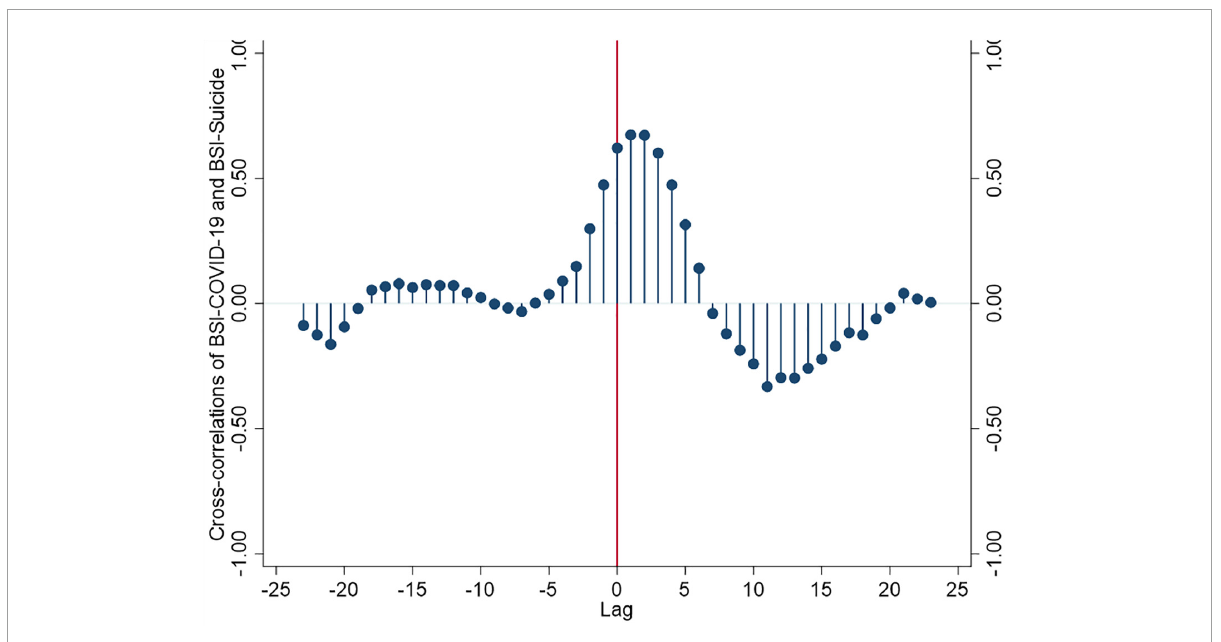
FIGURE2 A cross-correlation function for the weekly BSI-COVID-19 and BSI-suicide in